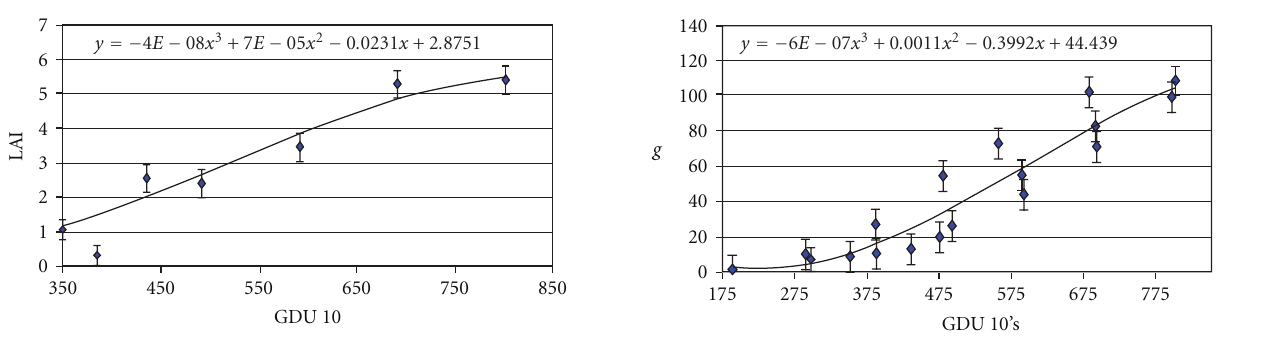
Figure 4: Dry Matter Accumulation per Plant (g) of Six Corn Hybrids (Four Glyphosate Resistant, One Glufosinate-Ammonium Resistant, and one Atrazine Resistant) From V3 to R1 Grown at Stoneville, MS in 2005, 2006, and 2007 and Treated with Herbicides or Cultivated for Weed